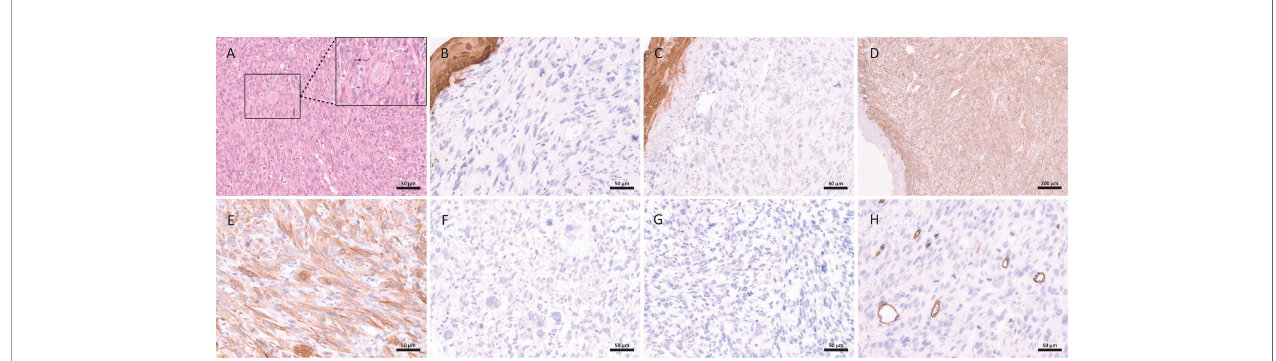
FIGURE 3 | Histopathological and immunohistochemical aspects of leiomyosarcoma of the penis: spindle cell malignant neoplasm with a high number of mitoses (white arrow) and atypical mitoses (black arrow) (A) ; the neoplasm was negative for epithelial markers: epithelial membrane antigen (B) and pan-cytokeratin (C) ; the immunohistochemical expression was strong and diffuse for smooth muscle markers: alpha-smooth muscle actin (D) and calponin (E) ; the neoplasm is also negative expression for: p16 (F) , S100 (G) and CD34